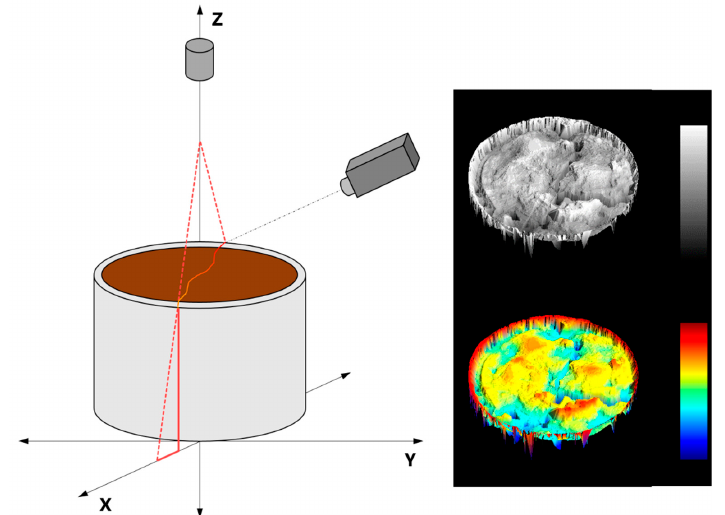
Figure 1. Soil-LT scanning operation with an undisturbed soil core (100 cm 3 ) rotating along the x-z plane (mm) while a coupled device camera (CCD) and a CMS 106 line laser (Control Micro Systems, Orlando, FL) detect and record the soil core surface (sample left) to create a 3D structure (samples right) using a software package (Umwelt-Geräte-Technik GmbH, Müncheberg,